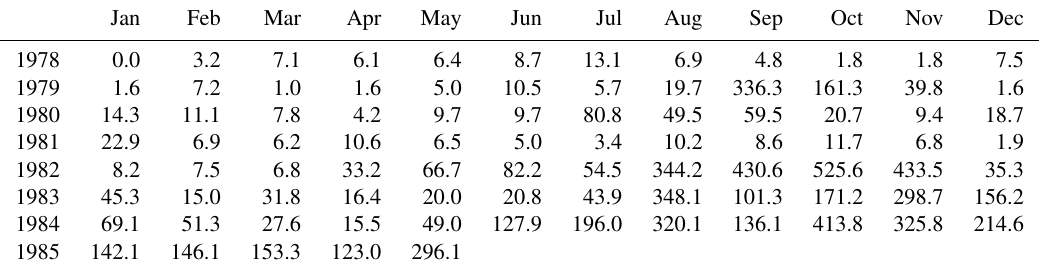
Table 1. Monthly horizontal displacement of A3 from January 1978 to May 1985 (in millimetres). Jan Feb Mar Apr May